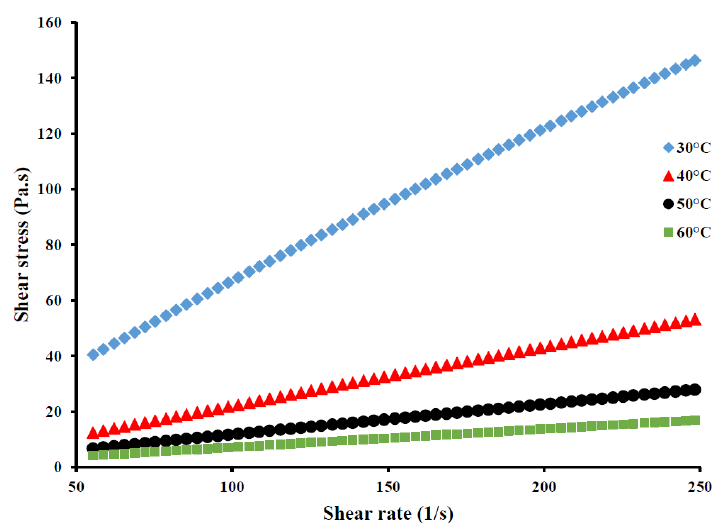
Figure 4. Impact of temperature on the flow model curves of CTO. Processes 2017 , 5 , 59